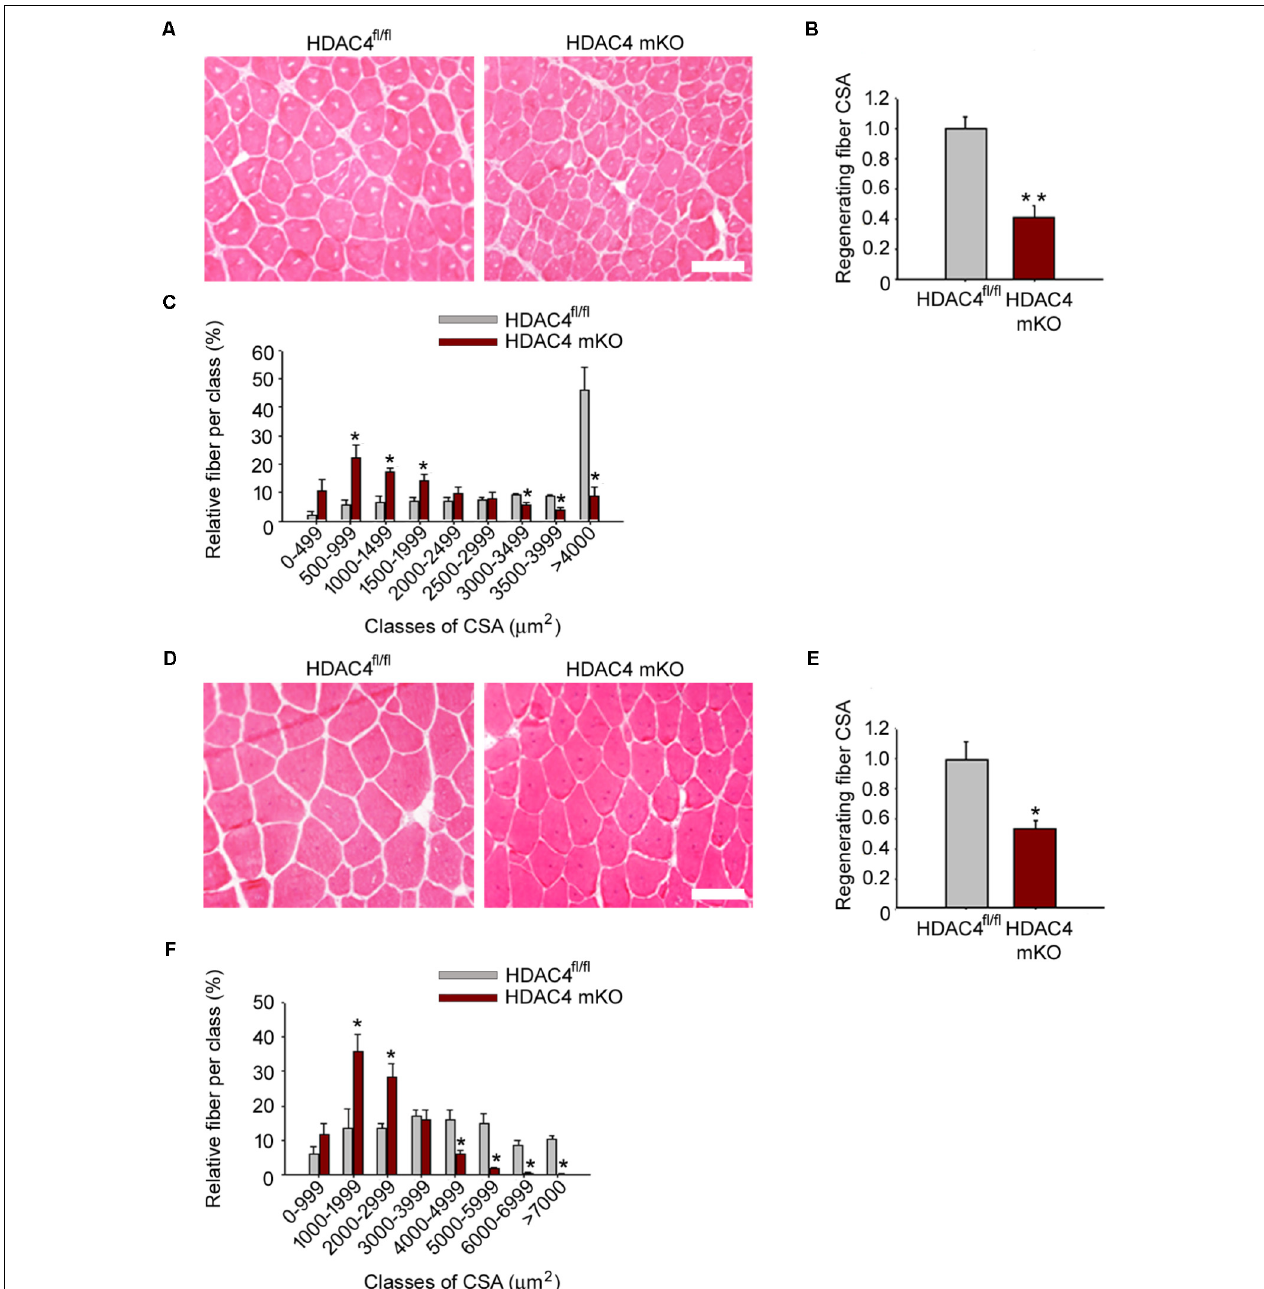
FIGURE 3 | HDAC4 mKO mice show impaired muscle regeneration. (A) Representative images of HDAC4 mKO and HDAC4 fl/fl tibialis anterior regenerating muscles, 2 weeks after injury. Scale bar = 50 micron. (B) Regenerating fiber CSA of HDAC4 mKO and HDAC4 fl/fl mice, 2 weeks after injury. Data are presented as median +/ − SEM. n = 8 mice for genotype. ∗∗ p < 0.02 by Student’s t -test. (C) Morphometric analysis of the distribution of regenerating fiber cross-sectional area, 2 weeks after injury. n = 8 mice for genotype. Data are presented as average +/- SEM. ∗ p < 0.05 by Student’s t -test. (D) Representative images of HDAC4 mKO and HDAC4 fl/fl tibialis anterior regenerating muscles, 1 month after injury. Scale bar = 50 micron. (E) Regenerating fiber CSA of HDAC4 mKO and HDAC4 fl/fl mice, 1 month after injury. n = 8 mice for genotype. Data are presented as median +/ − SEM. ∗ p < 0.05 by Student’s t -test. (F) Morphometric analysis of the distribution of regenerating fiber cross-sectional area, 1 month after injury. n = 5 mice for genotype. Data are presented as average +/- SEM. ∗ p < 0.05 by Student’s t -test.